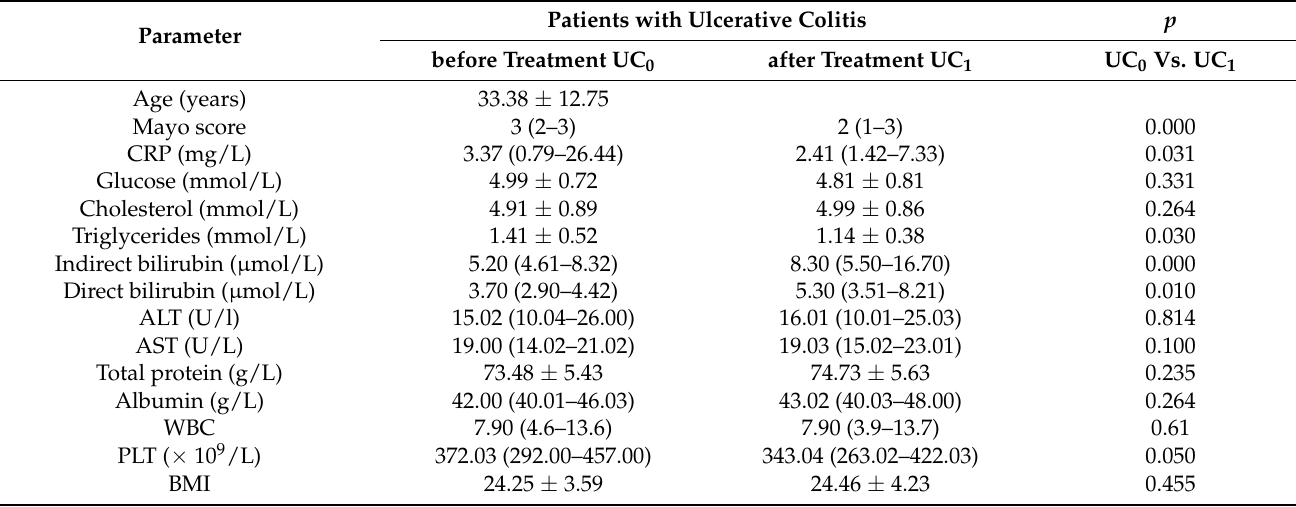
Table 1. Clinical characteristics of patients with ulcerative colitis (UC).